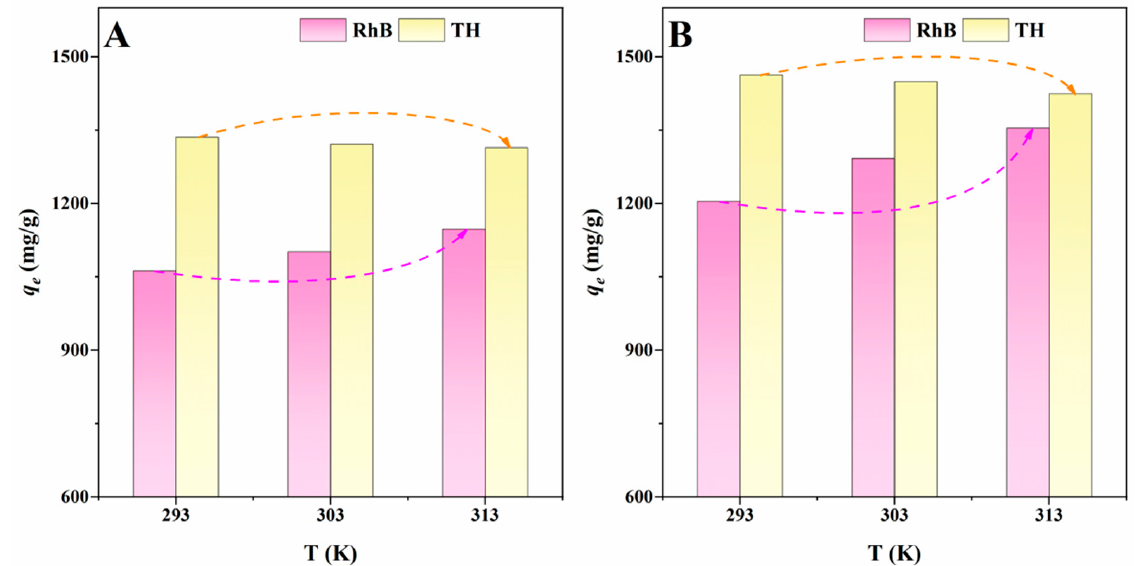
Figure 7. Adsorption thermodynamic of ( A ) ITGB and ( B ) MITGB. Table 4. Fitting adsorption thermodynamic parameters for RhB and TH.